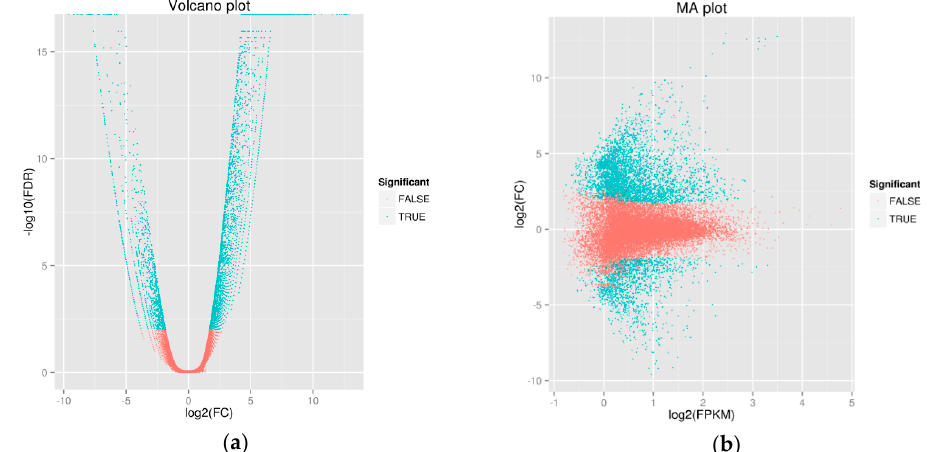
Figure 1. ( a ) Volcano plots of the differentially expressed genes (DEGs) in the comparisons of wild type (WT) and mutant type (MT) plants, ( b ) MA (Minus Average) plots of DEGs in the comparisons of WT and MT plants.